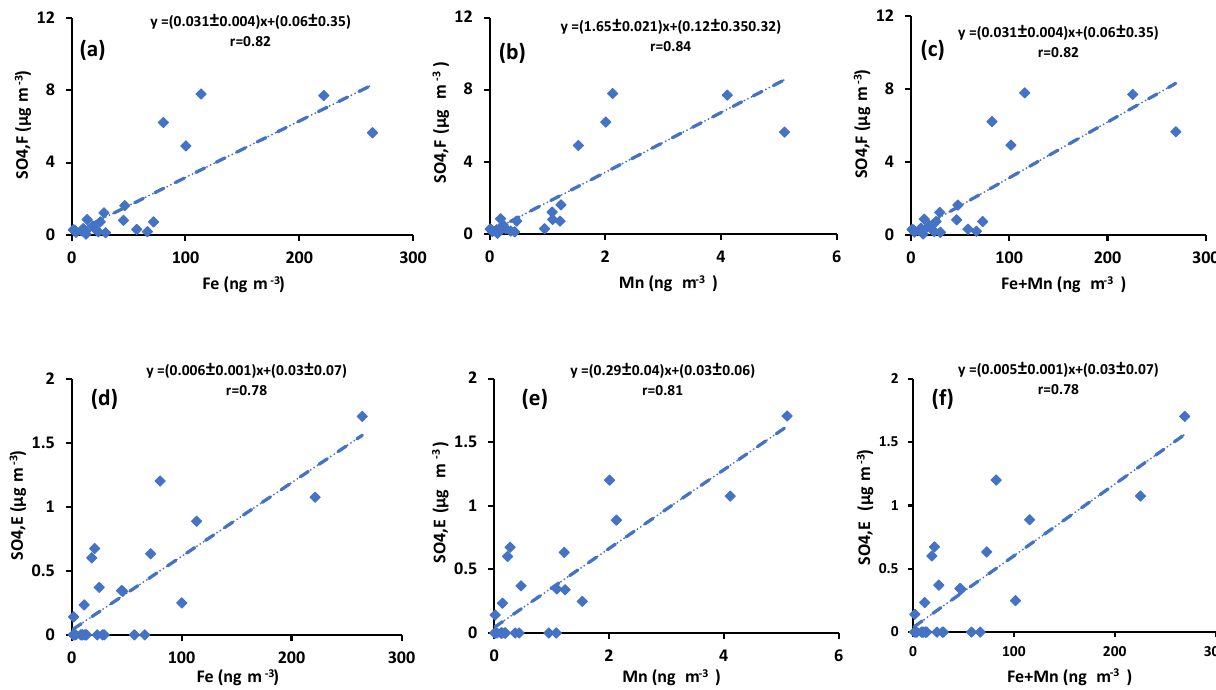
Figure A4. (a–c) SO 4 in size fraction F < 0 . 49µm versus the concentrations of Fe and Mn measured in PM 2 . 5 and the addition of Fe and Mn. (d–f) SO 4 in size fraction E 0 . 49 − 0 . 95µm versus the concentrations of Fe and Mn measured in PM 2 . 5 and the addition of Fe and